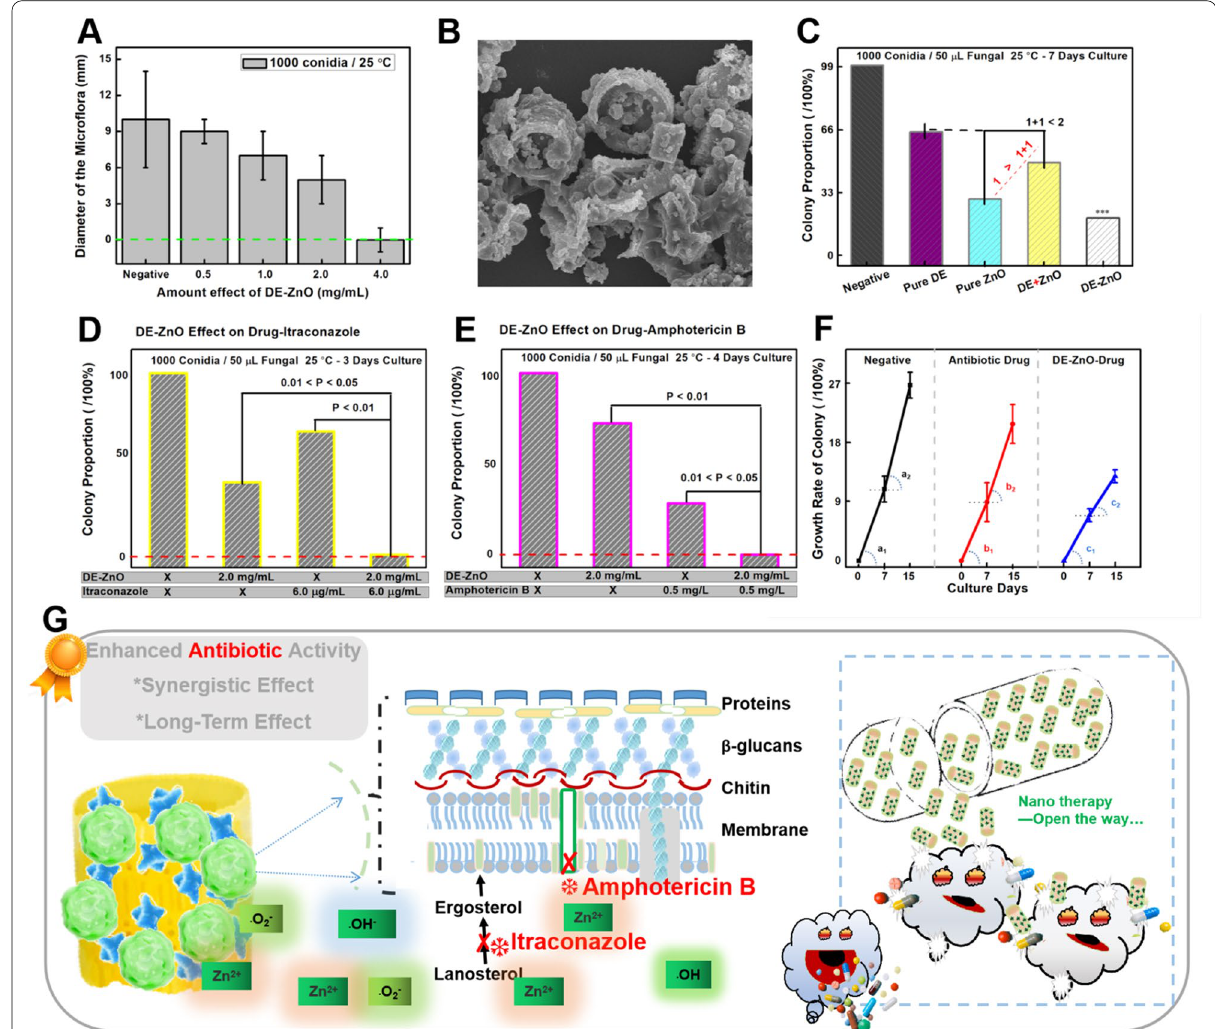
Fig. 3 Study the synergistic effect and persistence of DE‑ZnO composites against fungal infection. A Amount effect of DE‑ZnO on anti‑fungal activity (1000 conidia, 25 °C, culture for 3 days). Each data value is mean SE of duplicate independent experiments with 3 days culture. B SEM ± image of fungal aspergillus absorbed on the DE‑ZnO composites. C Growth tendency of fungi with a synergy effect between DE ZnO and pure + ZnO showing a “1 1 < 1” preference. Each data value is mean SE of duplicate independent experiments. D Antifungal activity of the DE‑ZnO + ± composite, itraconazole, and combination groups up to 3 days of culture with 1000 conidia. E Antifungal activity of the DE‑ZnO composite, amphotericin B, and combination groups up to 4 days of culture with 1000 spores. Each data value is mean SE of duplicate independent ± experiments. F Long term (15 days) culture of the fungi; growth rate of the colony reflects the enhanced synergy effect of the DE‑ZnO composites; growth tendency of the synergy effect between the DE‑ZnO composites and commercial drugs ( Amphotericin B and Itraconazole ). G Scheme of synergistic effect from a combination of DE‑ZnO and the existing drugs as a nano therapy